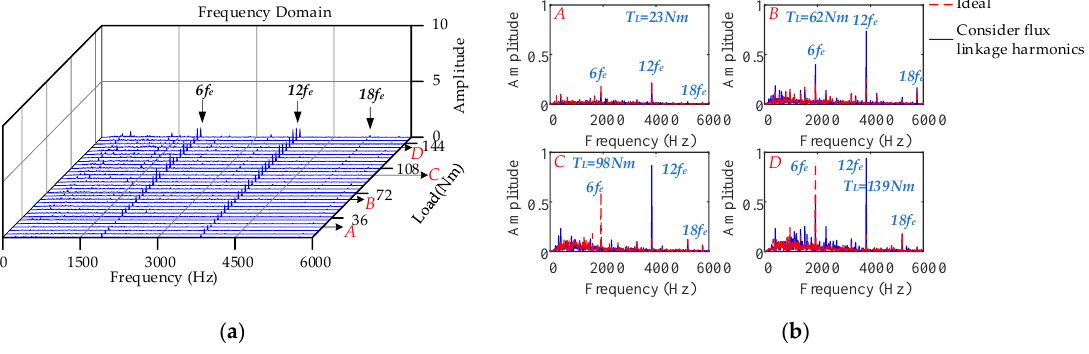
Figure 16. Frequency domain results of electromagnetic torque under different loads: ( a ) waterfall diagram of electromagnetic torque; ( b ) comparison results of electromagnetic torque.